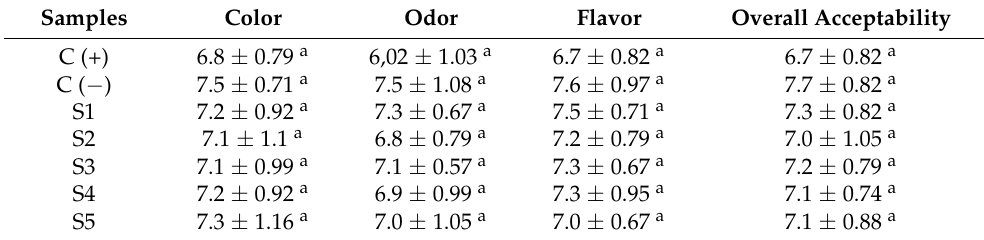
Table 3. Sensory evaluation. See Table 1 for details of the antioxidant composition of the salmon burger (mean ± SD). Different letters mean significant differences between cooked burger groups for each sensorial